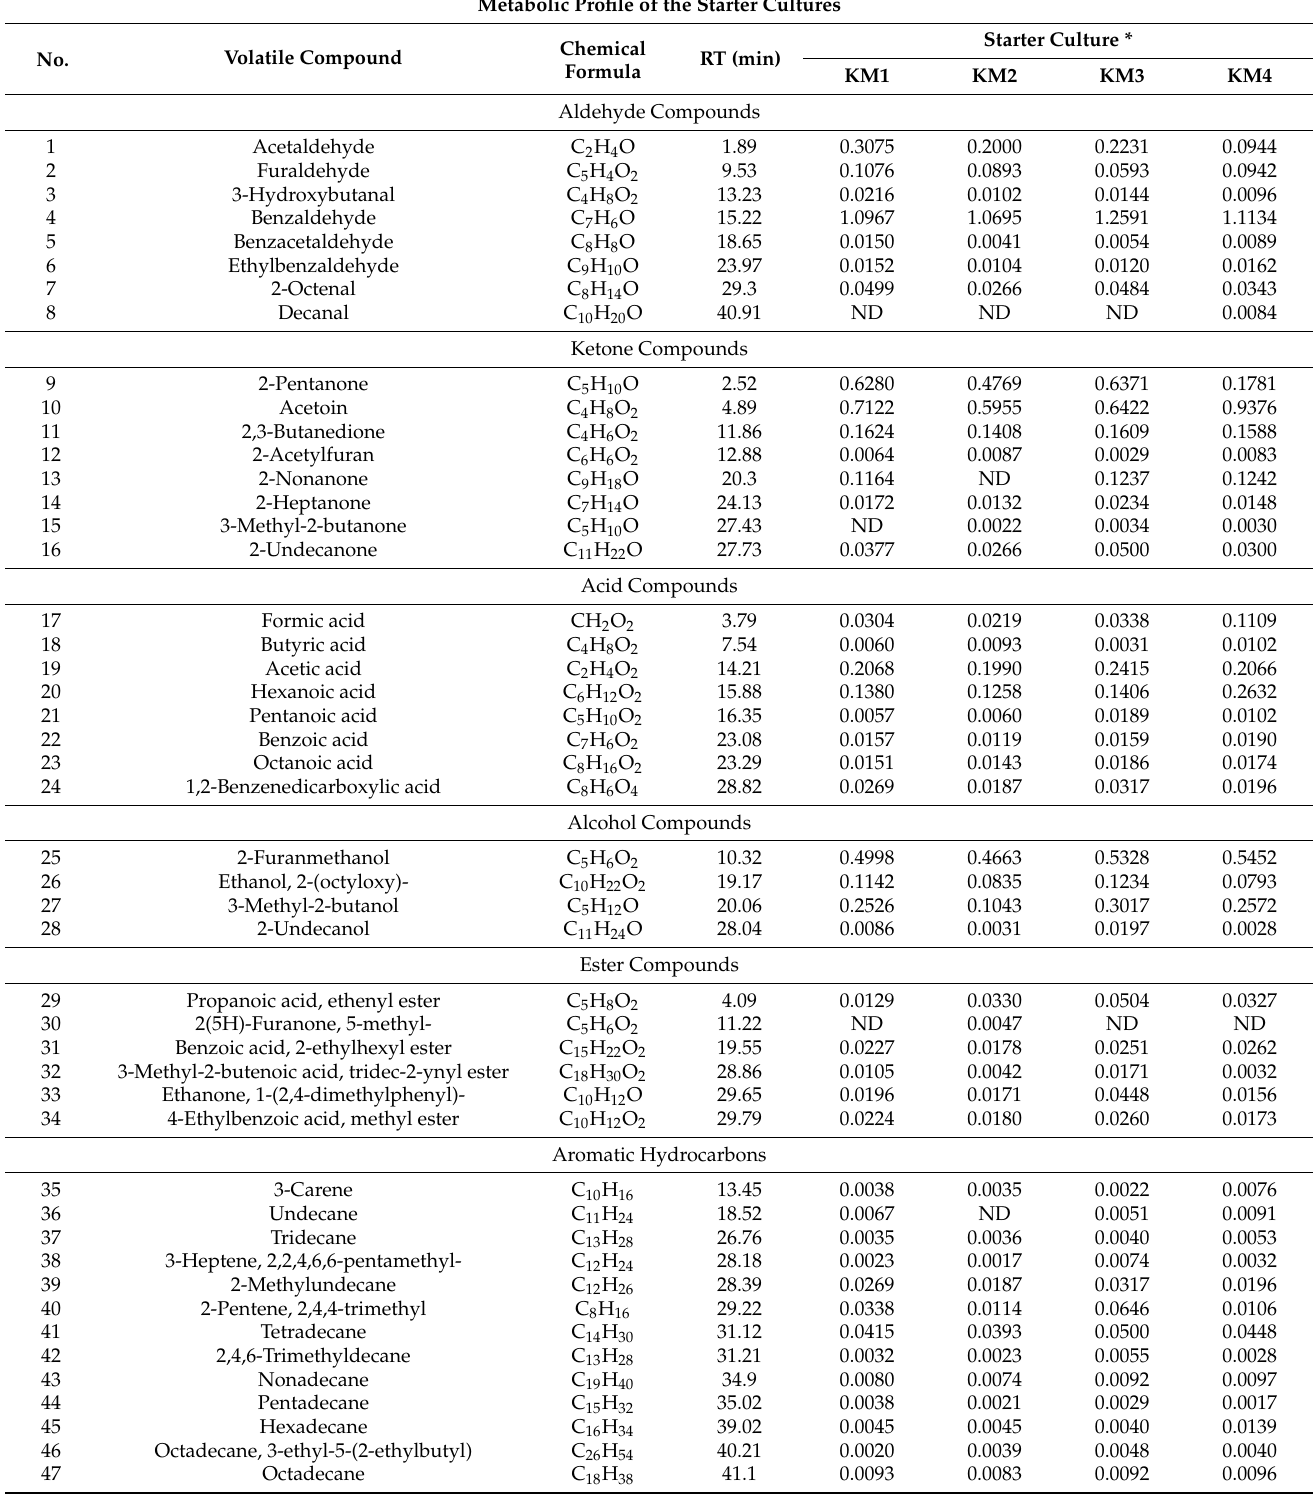
Table 2. Table 2. Aromatic components produced by symbiotic starter cultures KM1, KM2, KM3, and KM4. Metabolic Profile of the Starter